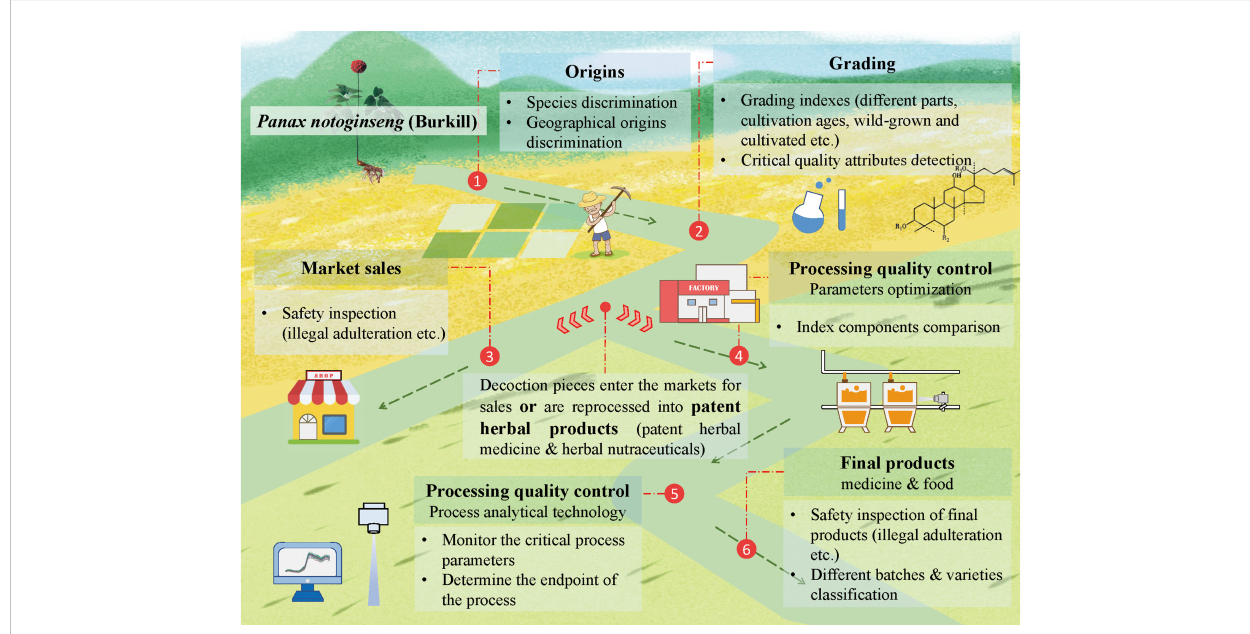
FIGURE 2 The quality and safety inspection of herbs across the whole process (set Panax notoginseng as a typical